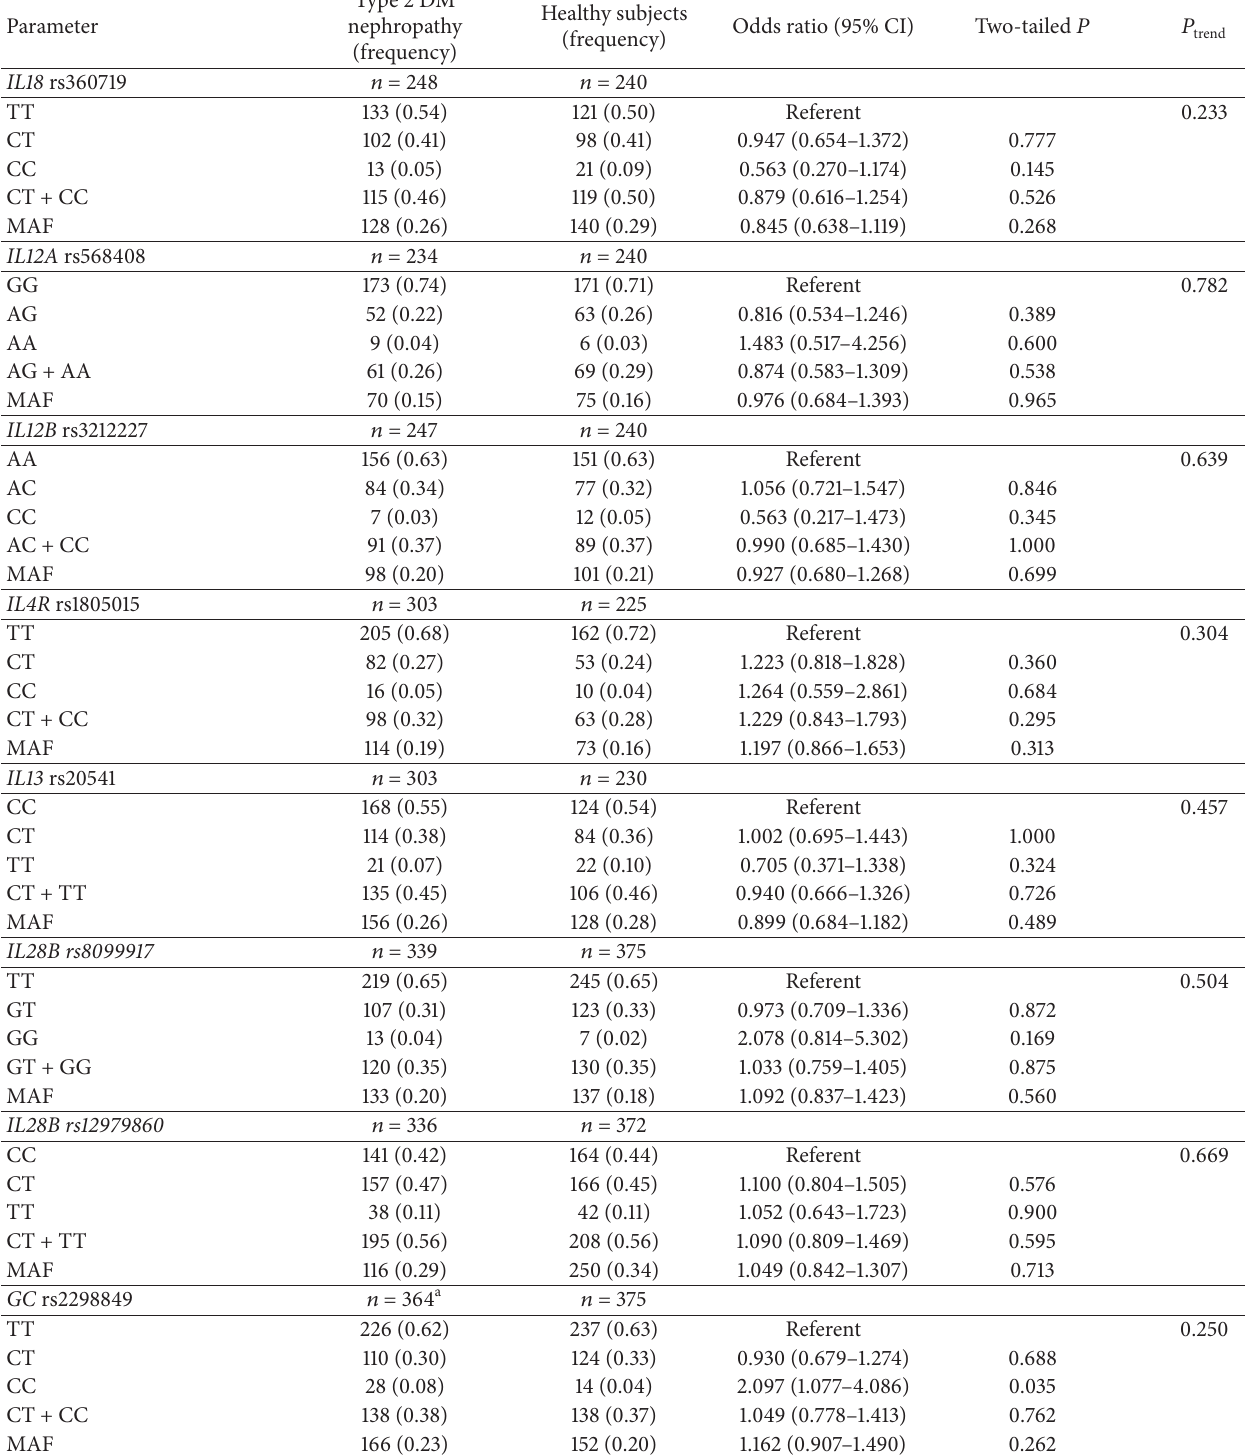
Table 4: Comparison of the distribution of polymorphic variants of tested genes between ESRD patients treated with hemodialysis due to type 2 DM nephropathy and healthy